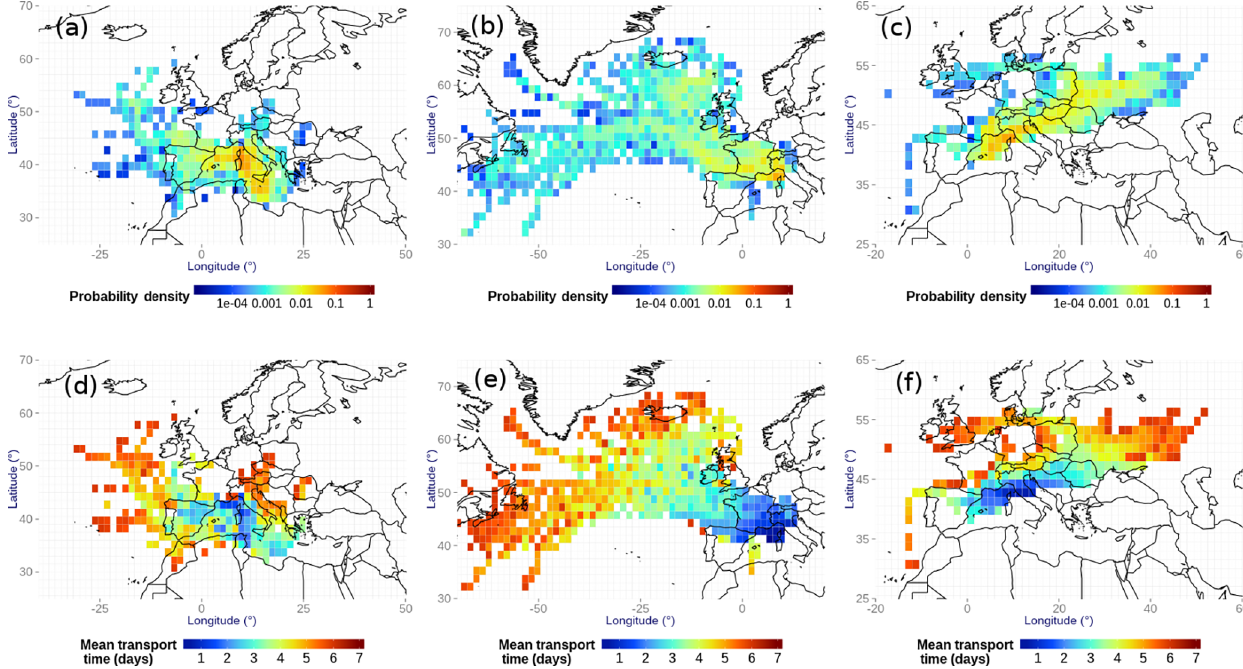
Figure 8. FLEXPART maps representing for (a, b, c) the probability density of the back trajectories for the three periods: dust, PMA and BBP. The bottom panels (d, e, f) represent the mean transport time from the Ersa station for the three periods: dust, PMA and BBP. Each back trajectory starts at 500m from the Ersa measurement